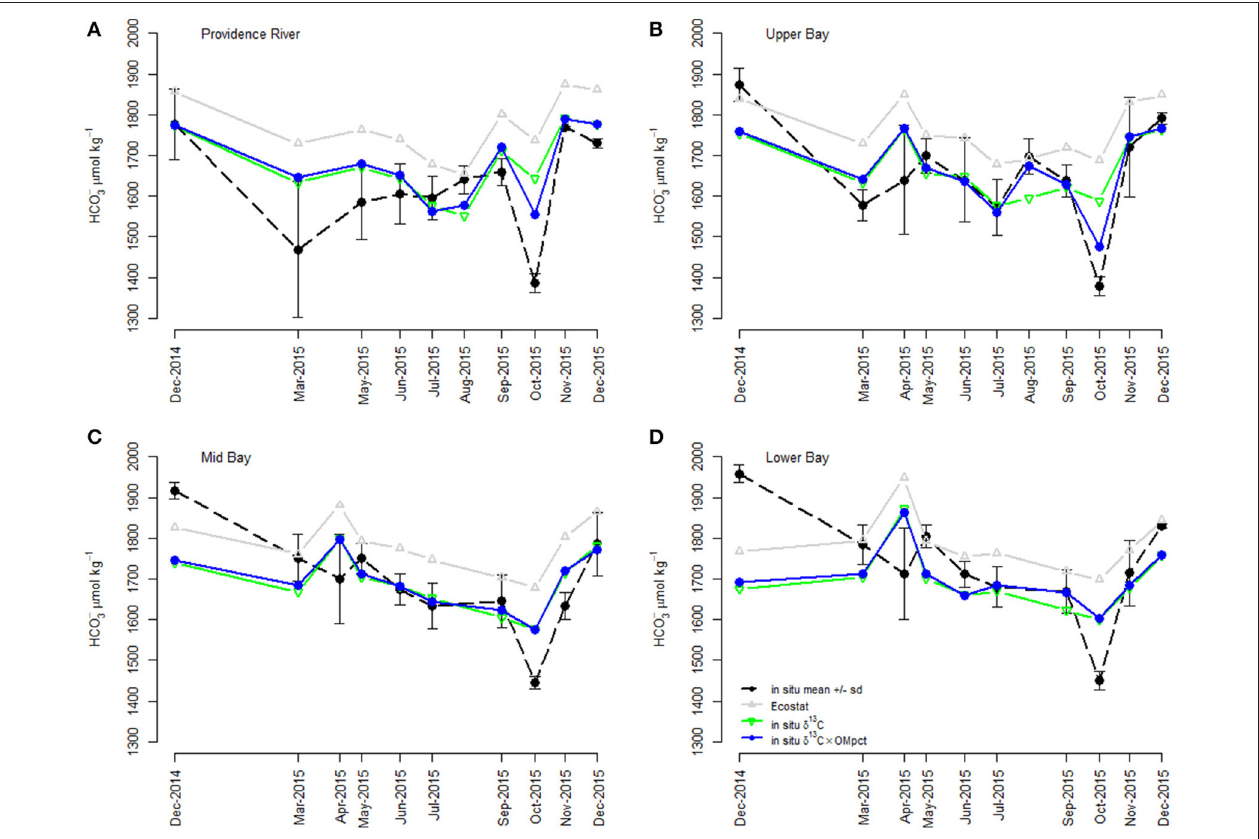
FIGURE 7 | Comparison of Ecostat-based predictions and empirical field-based models of [HCO − 3 ] in Narragansett Bay. The “ in situ ” points refer to [HCO − 3 ] calculated from DIC and TA in bottle samples from Narragansett Bay. “Ecostat” refers [HCO − 3 ] prediction via substitution of in situ δ 13 C into the regression of [HCO − 3 ] against δ 13 C in the Ecostat experiments. “ In situ δ 13 C” and “ in situ δ 13 C and OM” refer to predictors in their respective empirical relationship with in situ [HCO − 3 ]. The model containing δ 13 C and OM was the best empirical model of the field observations. Although the relationships are shown separately for each region within the bay for visual clarity, including region in the empirical models improved neither the goodness of fit (i.e., log-likelihood) nor the parsimony (i.e., AIC c; see Table 2 ). The regions of the Bay [e.g., Providence River (A) , Upper Bay (B) , Mid Bay (C) , and Lower Bay (D) ] are shown in Figure 2